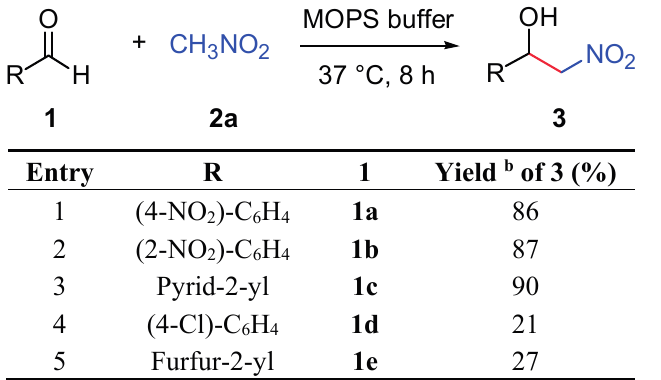
Table 2. Nitroaldol reaction in MOPS buffer between different aldehydes 1 and 2a . a MOPS buffer